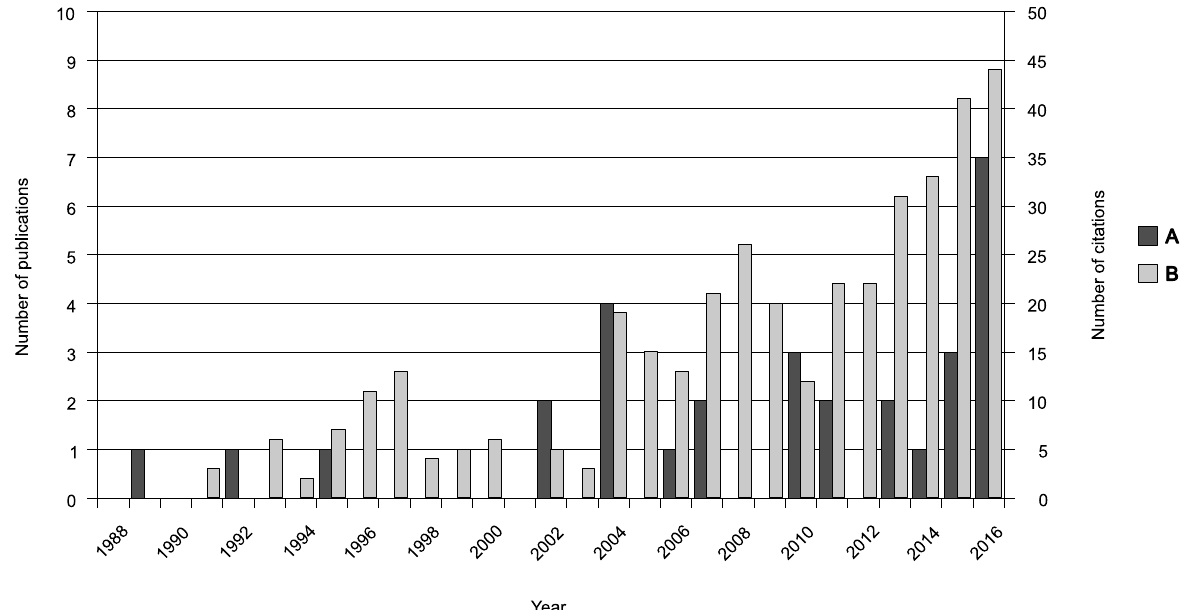
Fig. 2. Number of publications by Polish authors whose titles include the phrase “snow cover” (A) and number of citations of these publications in each year (B) according to the Web of Science (access on 24 July